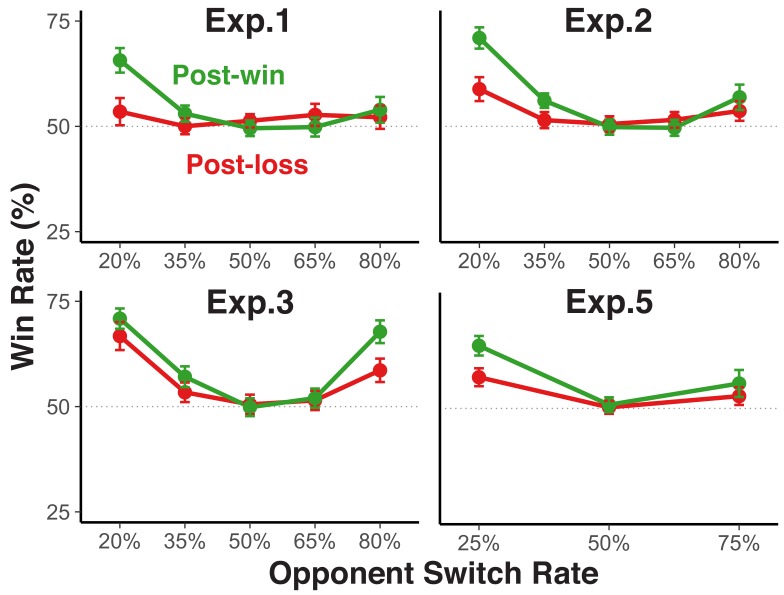
Rate of winning as a function of opponent switch rate and n-1 wins/losses.Model-based behavior can be useful only when the opponent exhibits some degree of regularity. Therefore, we expect that participants show a greater success rate both after win than after loss feedback and when the opponent’s switch rate deviates from chance (p=0.5). This figure shows rate of winning as a function of n-1 wins versus losses and opponents’ switch rate across all experiments with simulated opponents; results for Experiment 2 are collapsed across the two ITI conditions, which showed almost identical patterns. Error bars indicate 95% within-subject confidence intervals. The results confirm expectations: The success rate followed a right-tilted, U-curved function with the most wins for the lowest switch rate, followed by the highest switch rate, and no above-chance success for the mid-range switch rates. Most importantly, this pattern was much more robust for post-win than for post-loss trials. The fact that rate of winning was highest for the opponent with the lowest switch rate, in particular after win trials is consistent with the fact that participants showed a greater tendency for model-based behavior when it required them to engage in low rather than high rates of switching. Within each experiment, the main effect of n-1 wins versus n-1 losses was highly significant (all Fs >= 24.5, p<0.001), as was the interaction between this factor and the quadratic trend for opponent switch rates (all Fs >= 10.77, p=0.003).